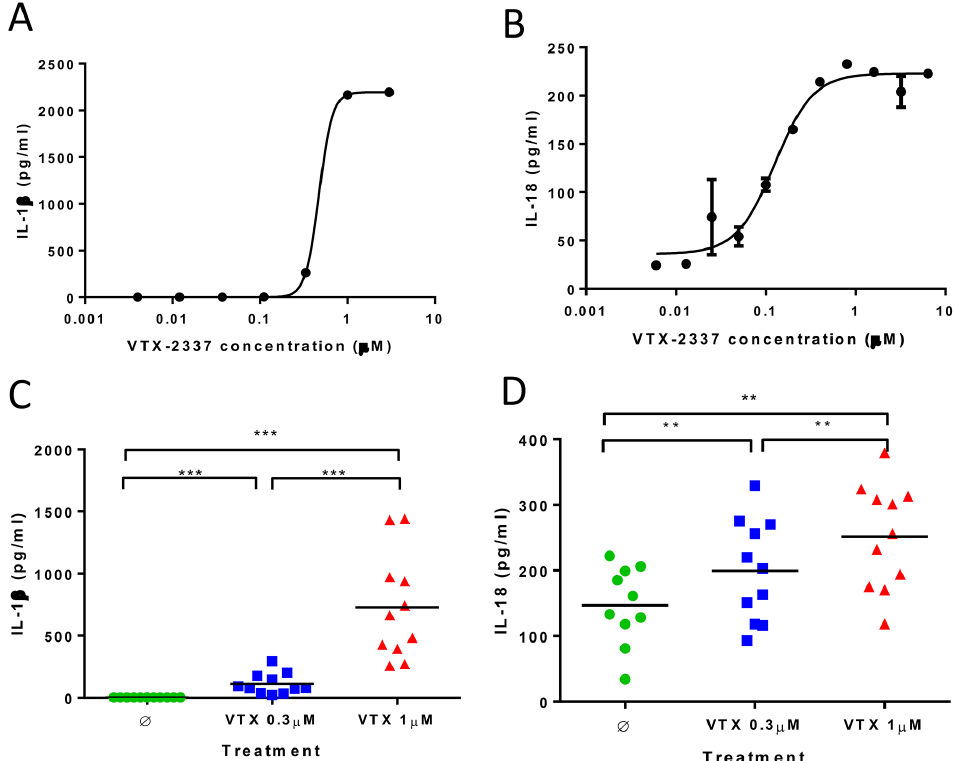
Fig 3. VTX-2337 induces IL-1 β and IL-18 in human PBMC. (A-B) IL-1 β and IL-18 secretion from VTX-2337 activated PBMC. Dose responses are shown for one representative donor, where data point represents the mean for duplicate culture wells at the indicated concentration of VTX-2337 after 24 h. (C-D) Summary graphs of VTX-2337-induced IL-1 β and IL-18 in whole blood from 11 donors, as analyzed by TruCulture. Whole blood was incubated with medium ( Ø ) or VTX-2337 (0.3 or 1 μ M) for 24 h, levels of secreted IL-1 β and IL-18 were analyzed in a multiplexed assay. Each symbol represents data from an individual donor. The horizontal bar represents group average. ** , p < 0.01; *** , p < 0.001 by Wilcoxon signed-rank test.